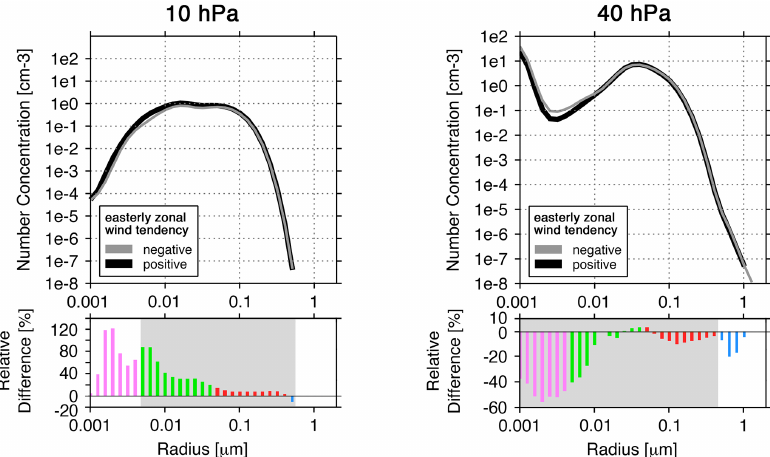
Figure 13. Comparison of modelled aerosol size distributions and associated QBO modulations, exemplarily at the 10 and 40hPa pressure levels. Inferred from monthly mean zonal means during the easterly phase of the QBO, when imposed anomalies in the integrated number densities (Fig. 10) may be phase shifted relative to the sign of the zonal wind tendency d U EQBO / d t . Bottom panels show corresponding relative differences between the two size distributions in each panel above and are binned according the particle’s size discretisation of the microphysical scheme (calculated relative to the negative tendencies’ average, i.e. the grey curve in the panels above). Grey shades in the bottom panel refer to those modes of the size distribution, where statistically significant QBO modulations have been determined in the integrated number densities according the standard Student’s t